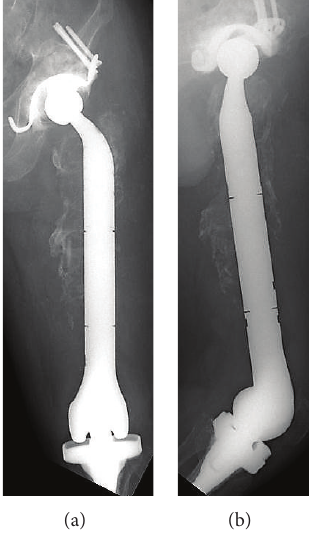
Figure 4: Postoperative radiographs of the left femur showing the total femur prosthesis as implanted. (a) Anteroposterior view. (b) Lateral view.